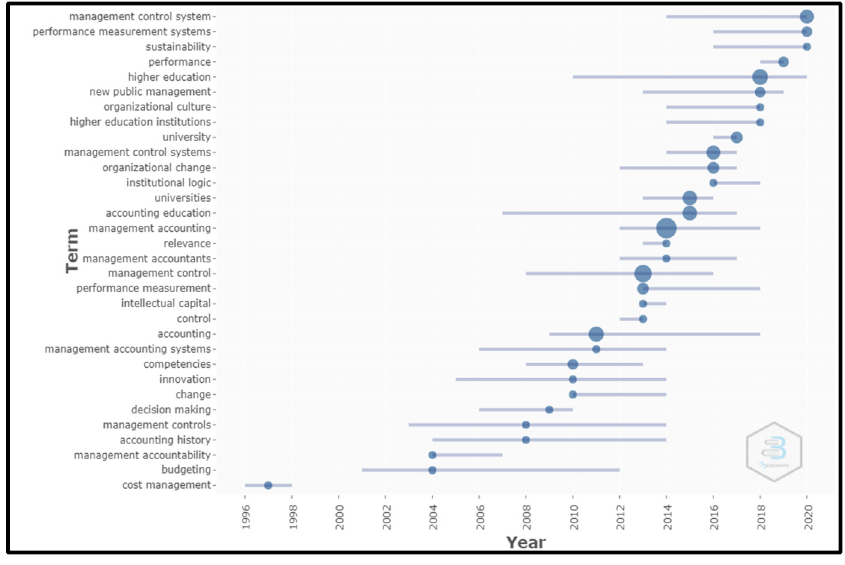
Figure 2. Trend topics.